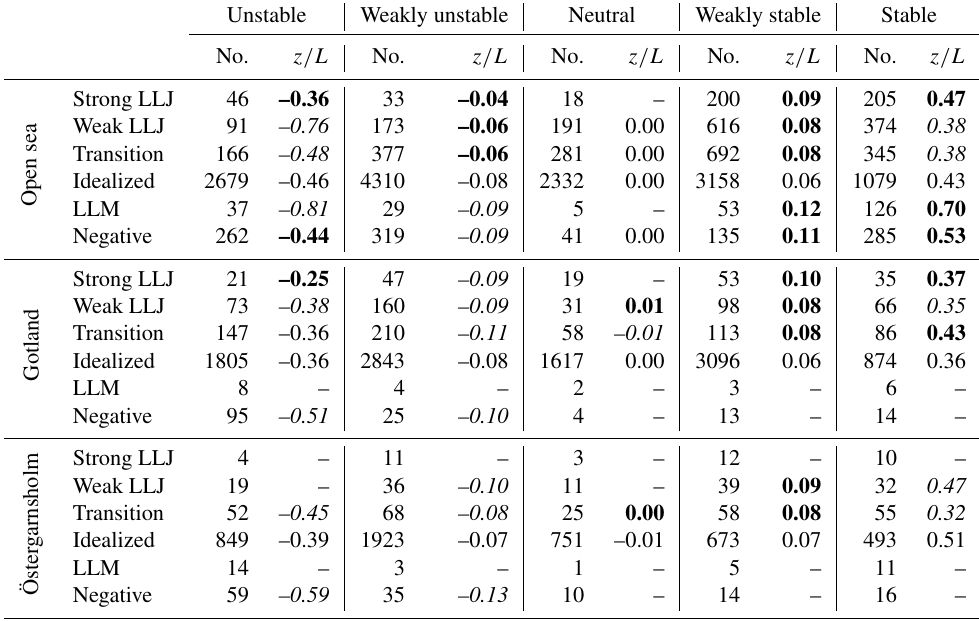
Table 1. Overview of the number of profiles (no.) and the median stability ( z/L ) for the spectral values plotted in Figs. 8 and 10 for the different wind direction sectors and under different atmospheric stabilities. Note that z/L values for profile types with less than 20 occurrences (per sector and stability) were omitted from being presented in the table. For each sector and each stability class, the values of z/L that are higher than the corresponding value for idealized profiles are marked in bold (representing a shift towards less unstable or more stable conditions), and the lower values are marked in italics (representing a shift towards more unstable or less stable